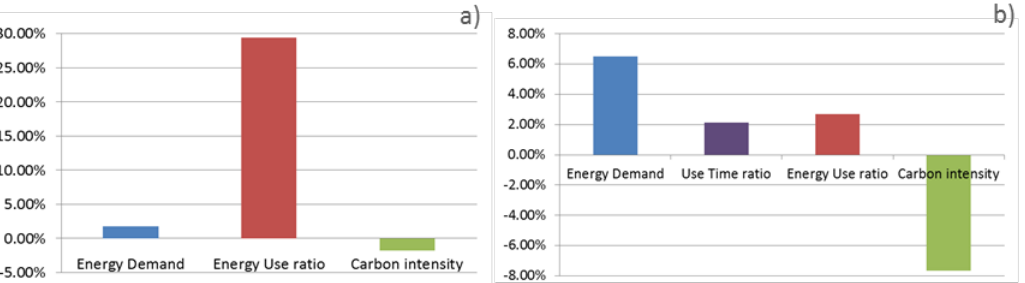
Figure 13. Indicator variation with 50% reduction of idle time ( a ) and indicator variation with 20% increase of residential NN distance compared with the base case ( b ).